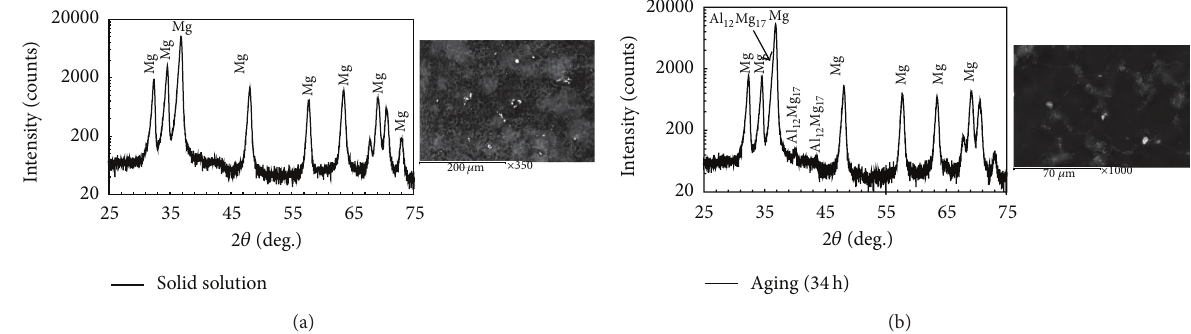
Figure 2: X-ray diffraction patterns of (a) solution treated and (b) aged AZ61 alloy for 34hr.